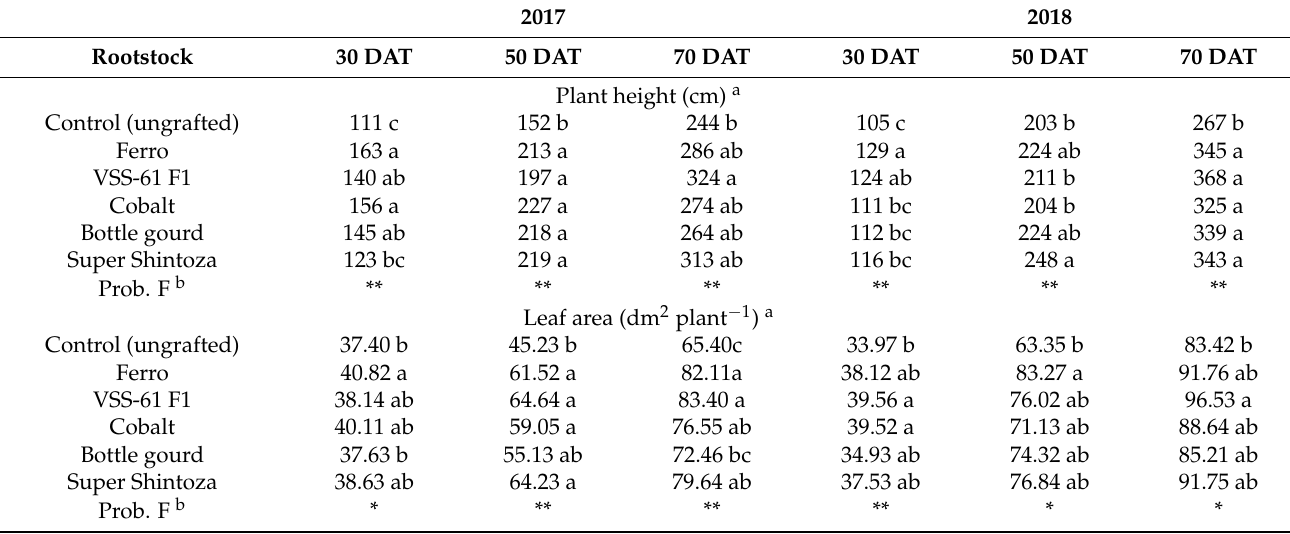
Table 2. Mean values for plant height and leaf area of Gianco F1 cucumber plants grafted onto five cucurbit rootstocks and the ungrafted control at 30, 50, and 70 days after transplanting (DAT) under heat and salinity stresses in the 2017 and 2018 seasons. Details on the measurement of the traits presented are provided in the Material and Methods